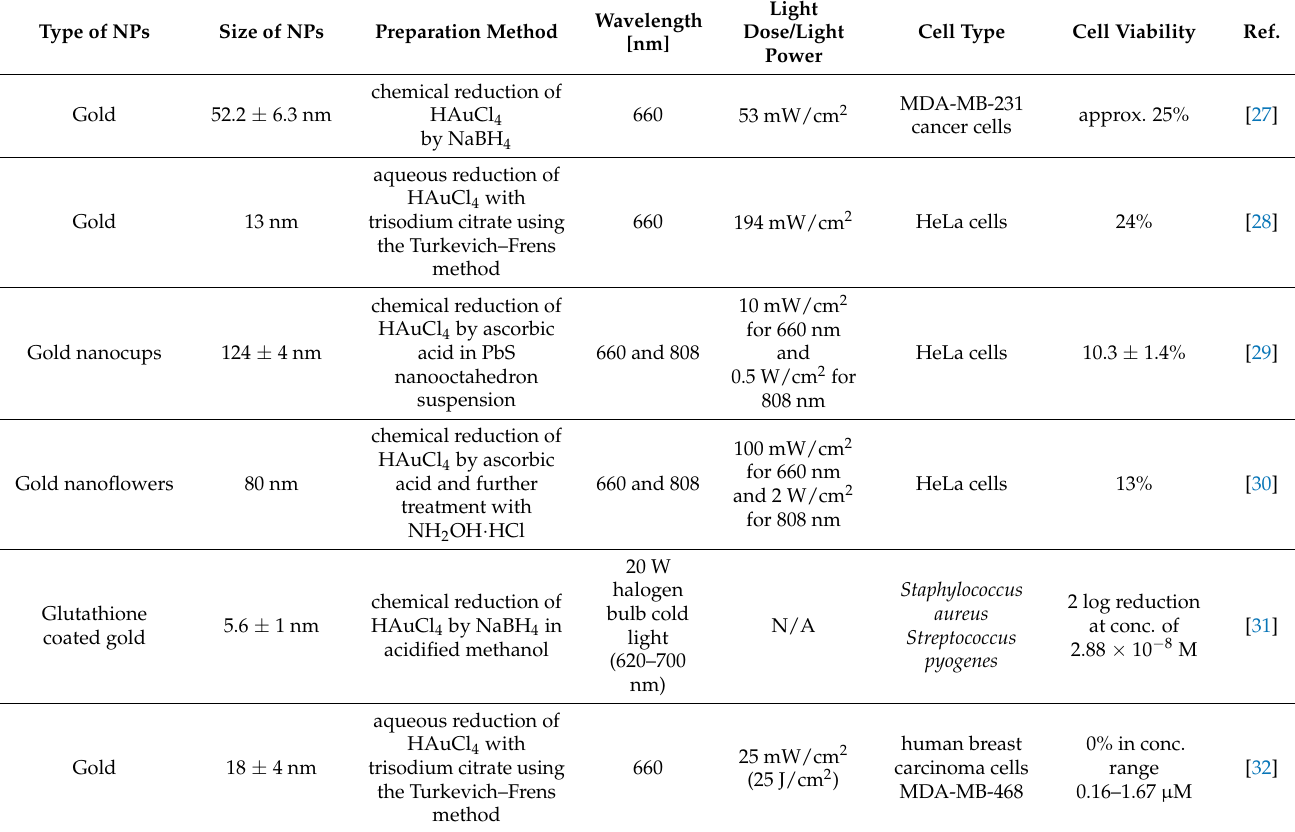
Table 2. Summary of the data presented in Section